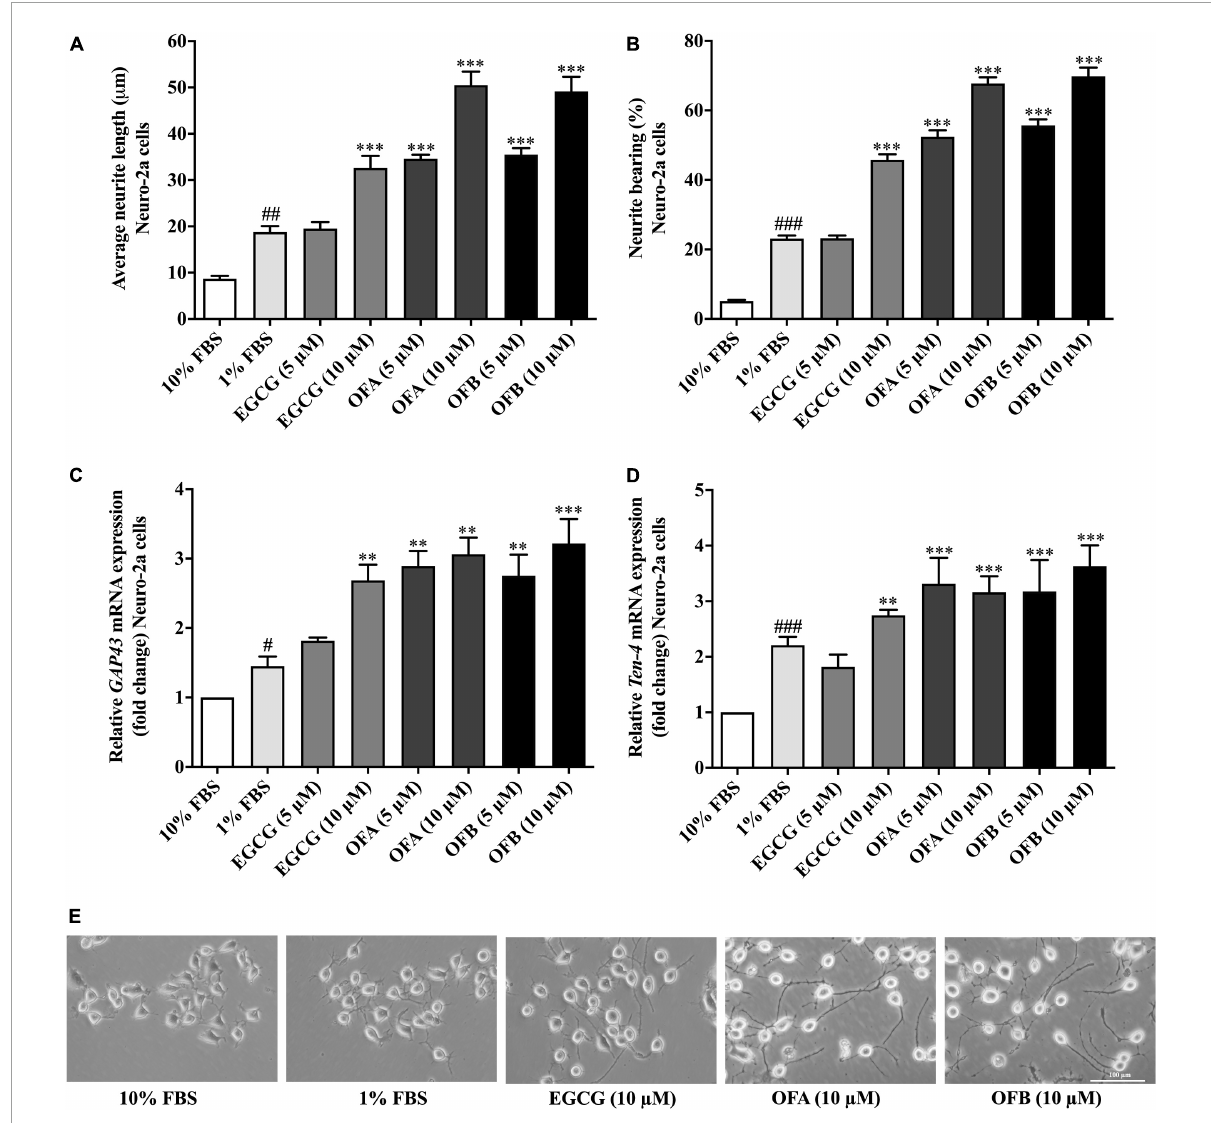
FIGURE2 Effect of EGCG, OFA, and OFB on neurite outgrowth. After treated with EGCG, OFA, and OFB in Neuro-2a cells, the average of neurite lengths (A) and the percentage of neurite-bearing cells (B) were measured. Relative GAP-43 (C) and Ten-4 (D) mRNA expression levels represented as fold change compared to the 10% FBS control in Neuro-2a cells. The images of cell morphology were taken under a 10 magnification microscope (E) . β -Actin was used in RT-PCR assay as internal control. Results were normalized to 10% FBS control level and shown as the mean ± standard deviation ( n ≥ 3 independent experiments). # p < 0.05, ## p < 0.01, and ### p < 0.001 compared to the 10% FBS control; ∗∗ p < 0.01 and ∗∗∗ p < 0.001 compared to the 1% FBS